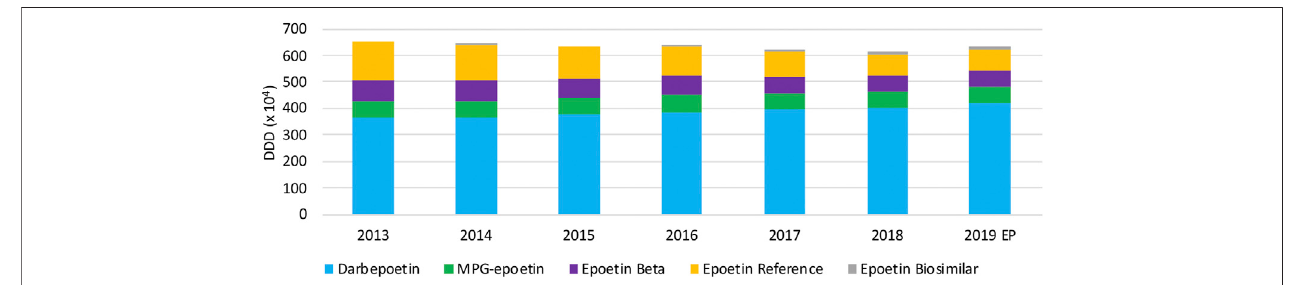
FIGURE 9 | Total volume (DDD) evolution of epoetins between 2013 and 2019. EP: Extrapolated data.